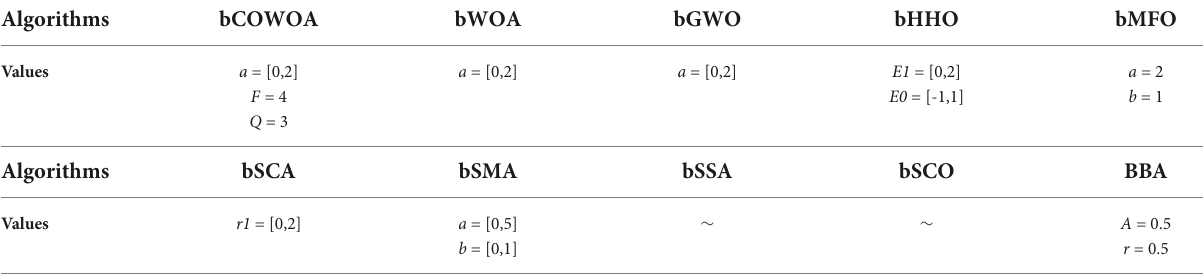
TABLE 13 Key parameters of the